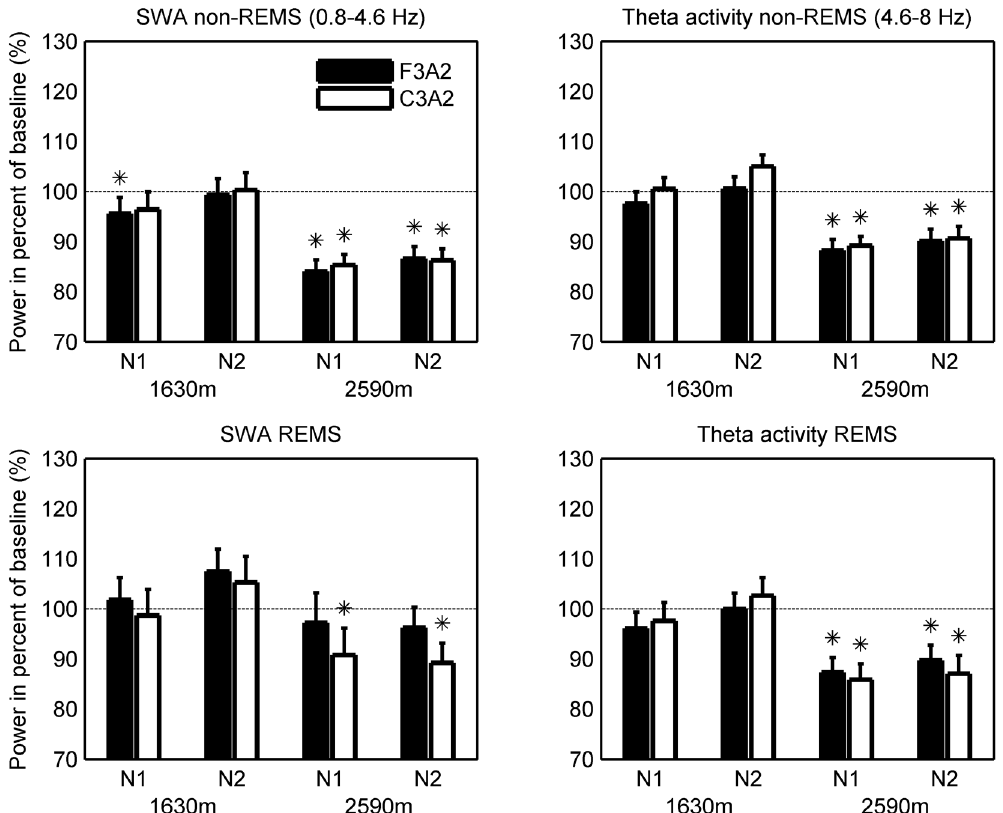
Figure 2. Relative slow-wave and theta activity at moderate altitude. Mean (SEM; n=44) slow-wave (SWA; 0.8–4.6 Hz) and theta activity (4.6–8 Hz) in non-REM and REM sleep (REMS) at altitude (1630 m and 2590 m, N1 [first night] and N2 [second night] at a particular altitude) expressed as percentage of baseline sleep at 490 m (100%; dotted line). F3A2: Frontal derivation; C3A2: Central derivation. *p , 0.05 (paired t-test altitude compared to